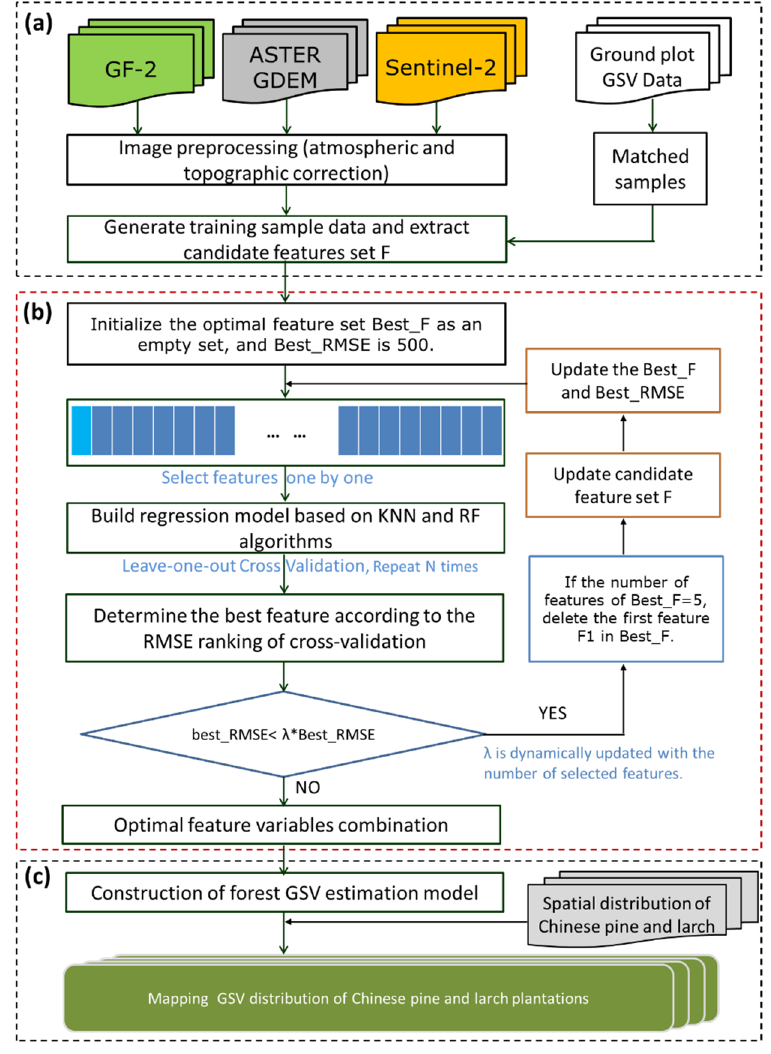
Figure 3. Methodological framework for forest GSV estimation based on the adaptive feature combination optimization program (AFCO). ( a ) Data preparation and feature variables extraction; ( b ) flow chart of adaptive feature combination and optimization program; ( c ) modelling and mapping the GSV of coniferous plantation.